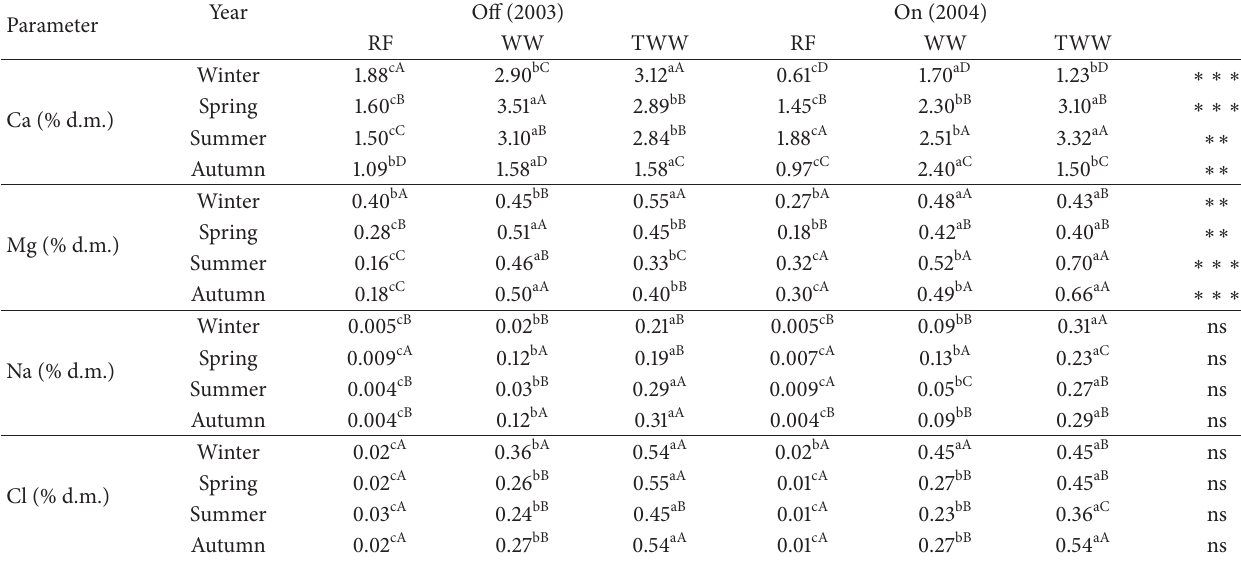
Table 3: Roots Ca, Mg, Na and Cl contents in the three treatments: rainfed (RF), well water (WW), and treated wastewater (TWW) in “on” and “off” year. Parameter